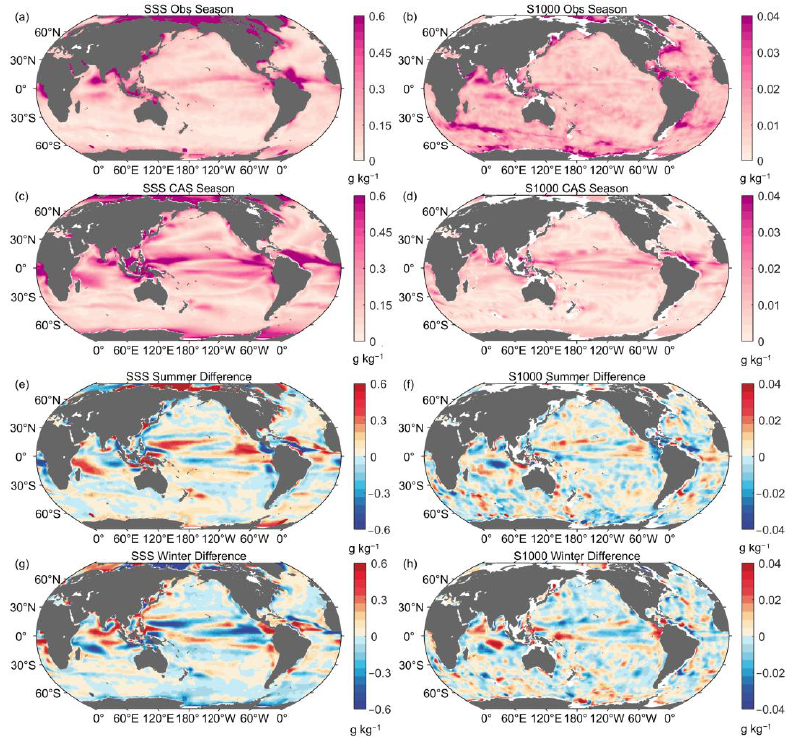
Figure 4. Seasonal variation magnitudes of the ( a ) sea surface salinity (SSS) and ( b ) 0–1000 m averaged salinity (S1000) for the observational mean, ( c , d ) for the CAS-ESM2-0 model. Mean differences between the model and observational mean in summer and winter for the ( e , g ) SSS and ( f , h ) S1000. The monthly anomalies are obtained from the 12-month climatological means, which has removed the annual mean during 1990-2010. The magnitude of seasonal variation is defined by the standard deviation of time variation. The averages of summer and winter are obtained for June-July-August and December-January-February, respectively.